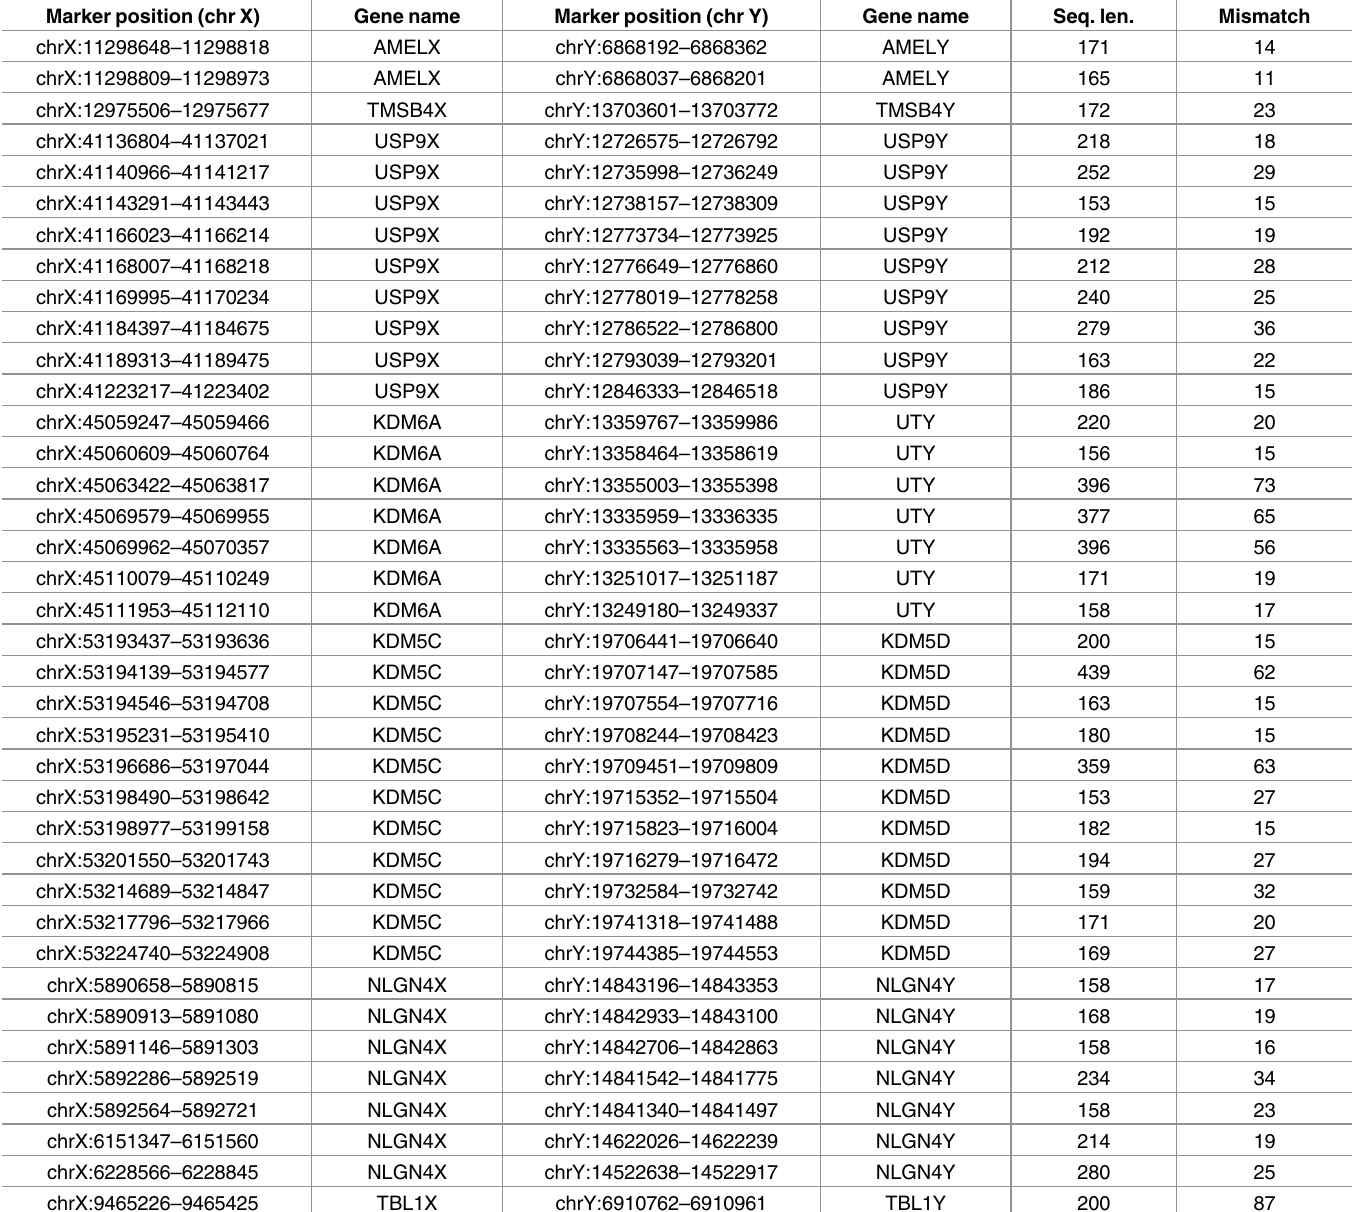
Table 2. Sex-specific markersequences for humans. Marker position (chr